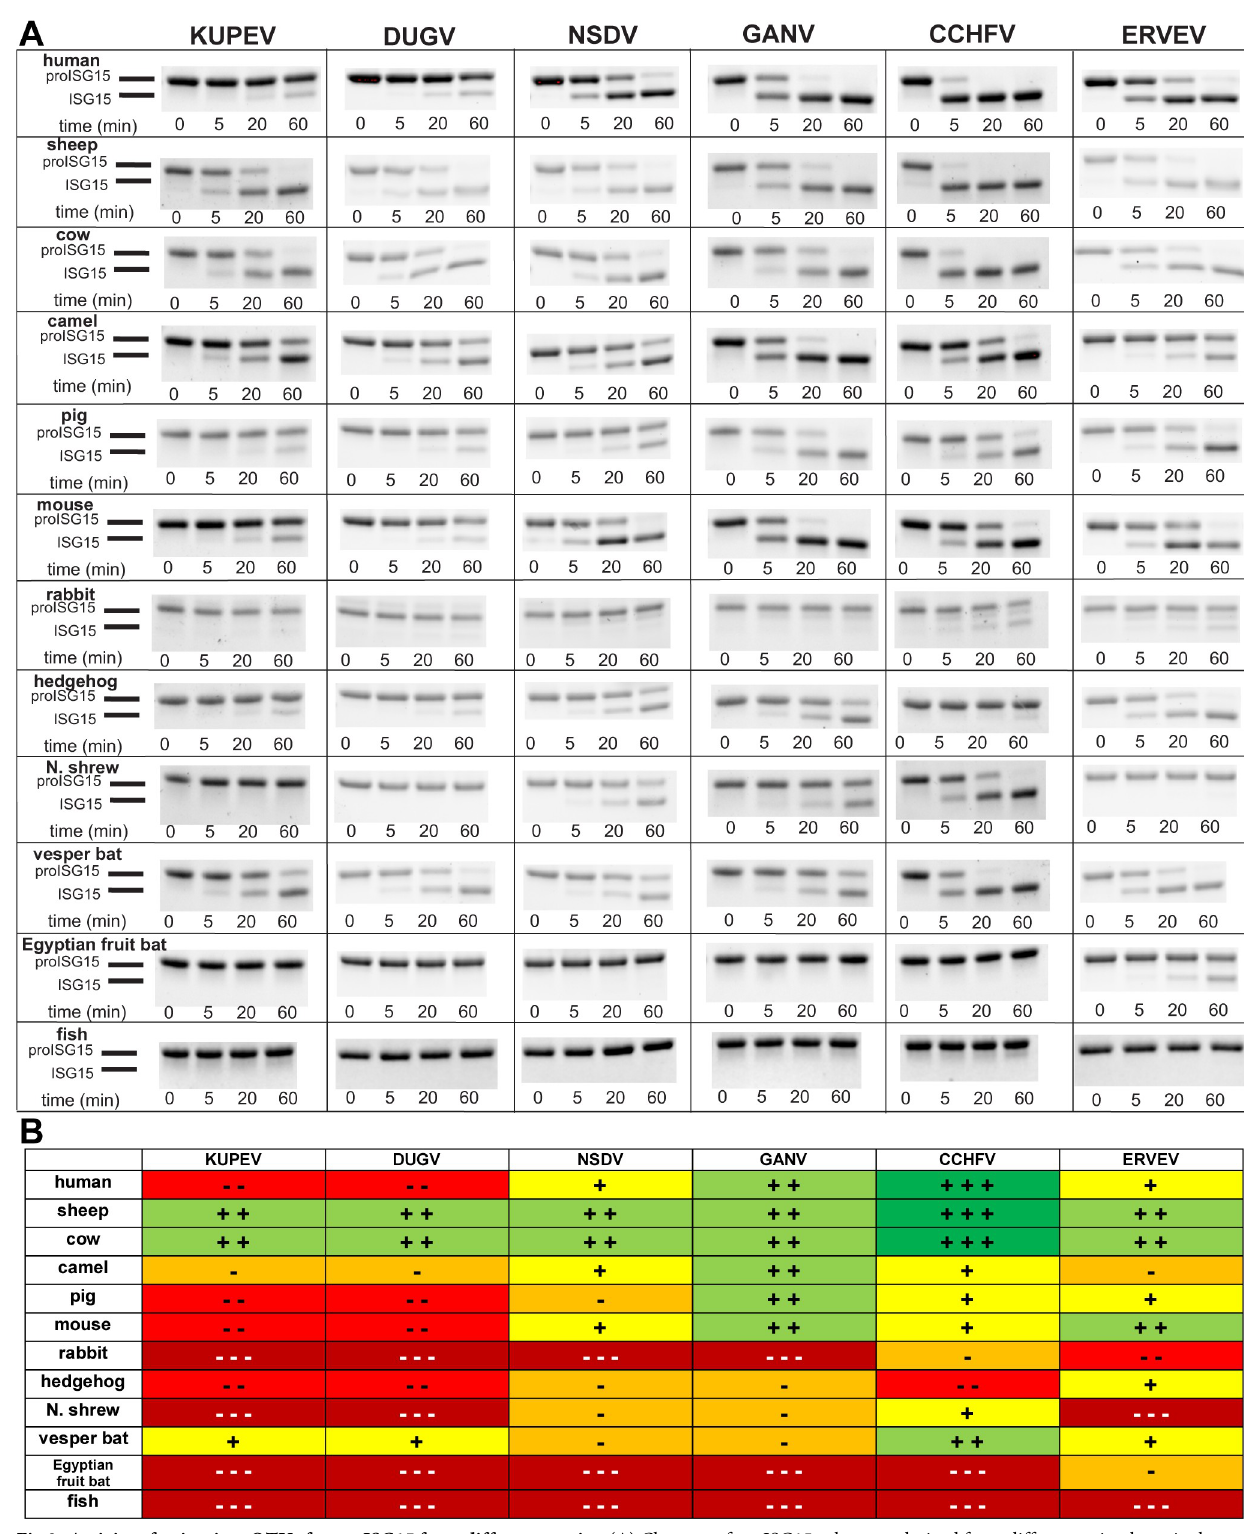
PLOS ONE | https://doi.org/10.1371/journal.pone.0226415 December23,